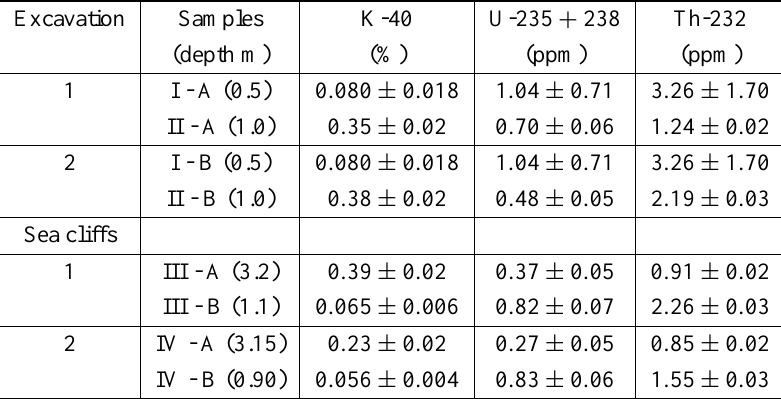
Sample names and related natural radioisotope